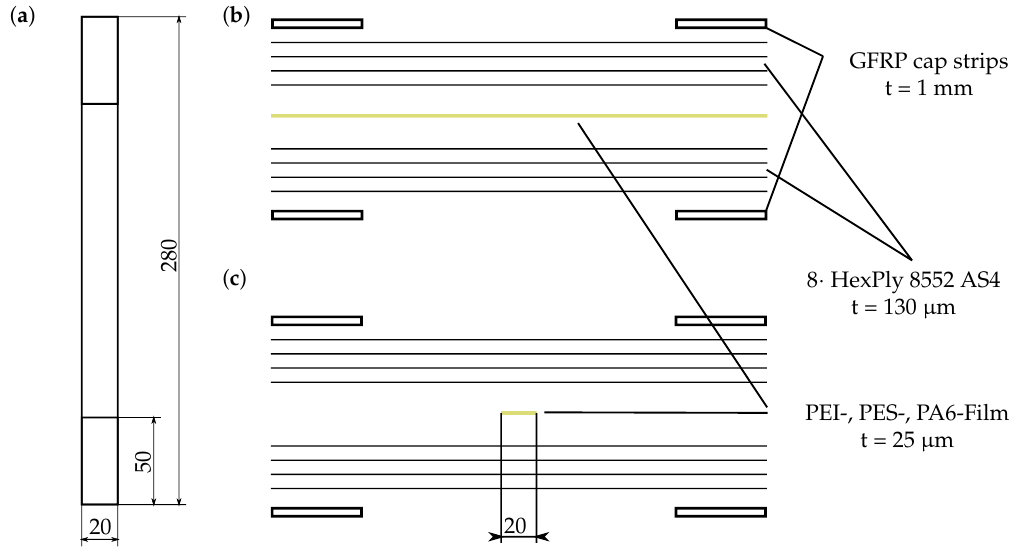
Figure 4. Geometry and layup of tensile test specimens. ( a ) Specimen geometry. ( b ) Specimen with integrated thermoplastic film. ( c ) Specimen with integrated thermoplastic film